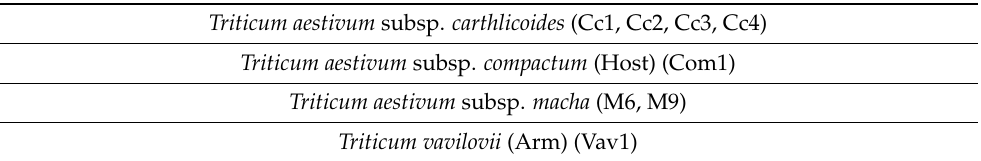
Table 9. Hexaploid wheats with matching values of fourth intron of Wknox1d and fifth-to-sixth exon region of Wknox1b